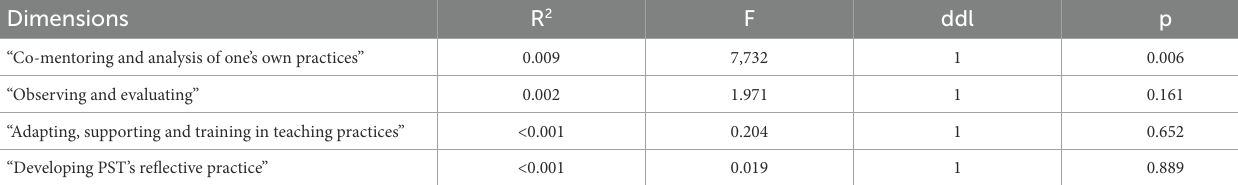
TABLE 6 Linear regressions between teacher length of service (in years) and factor